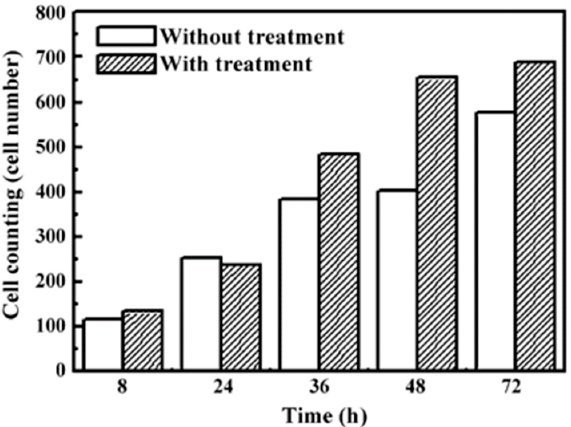
Figure 17. Cell counting performed on the treated and EDMed Fe-Al-Mn alloy [122]. (With kind permission from Elsevier).